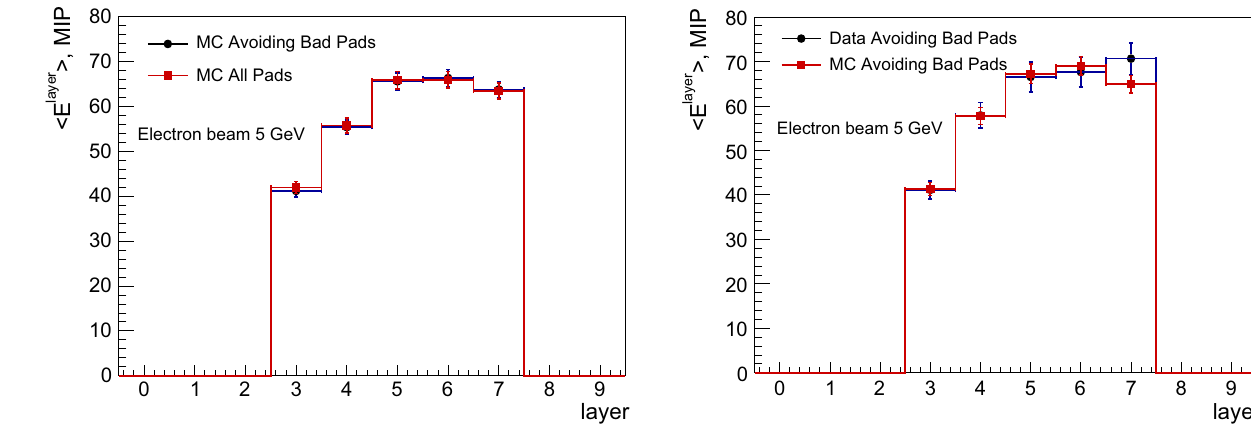
Fig. 19 Longitudinal shower, comparison between simulations with and without bad channels. The distributions are obtained with a 5 GeV electron beam